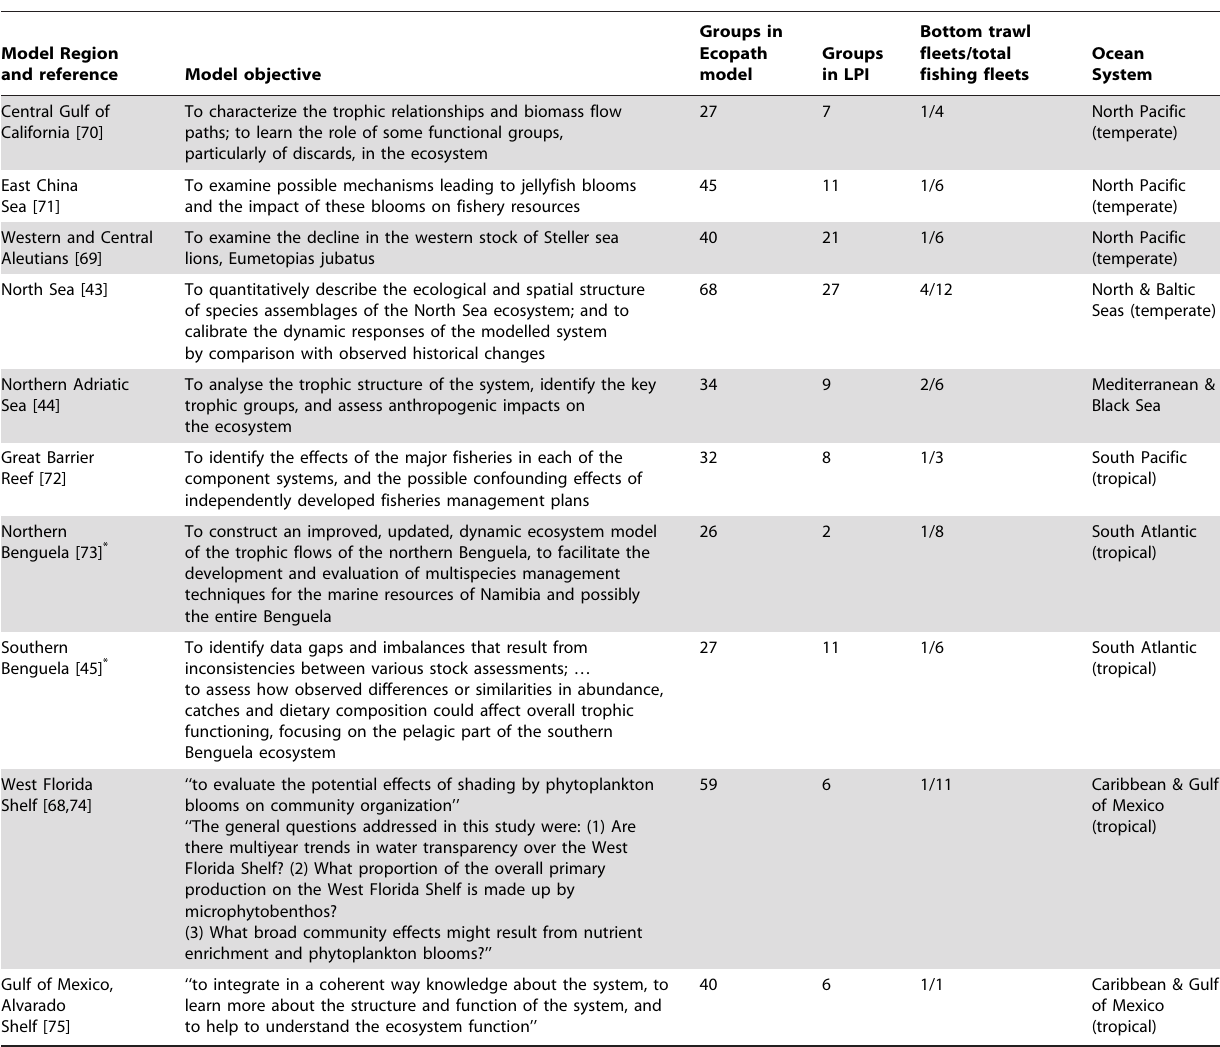
Table 3. The ten Ecopath models used to simulate the policies of ending and halving bottom trawling, the stated objectives in the studies in which the models are described, the number of functional or taxonomic groups each model contained, the number of these groups represented in the LPI, the fraction of fishing fleets that were bottom trawl-based and thus affected by the policies, and the ocean system the region lies